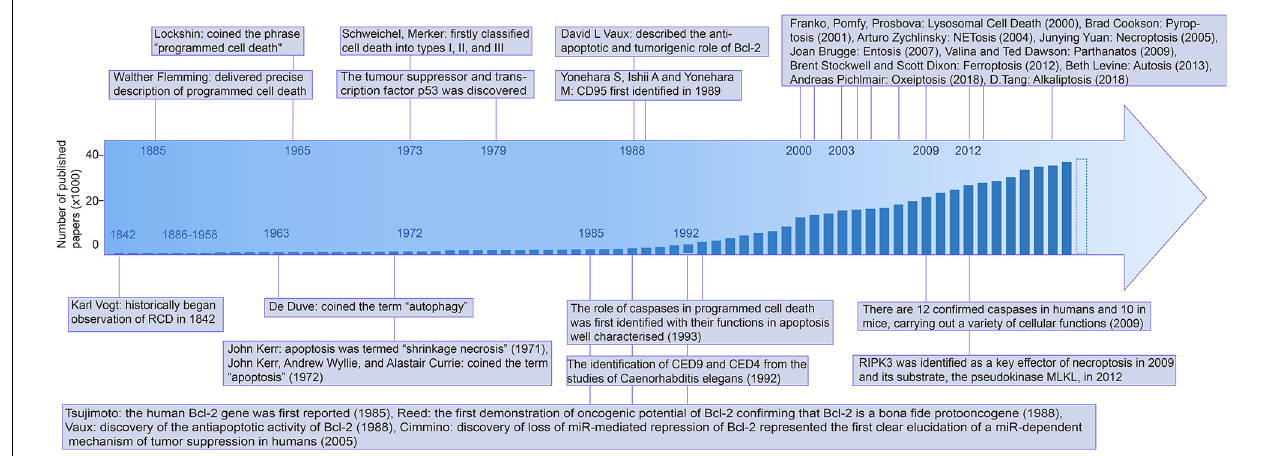
FIGURE 1 | Timeline of the mile stone of cell death research. Abbreviations: Bcl-2: B-cell leukemia/lymphoma-2, CED-9: Cell death abnormality gene 9, RIPK3: Receptor-interacting serine/threonine-protein kinase 3, MLKL: Mixed lineage kinase domain like pseudokinase, PCD: Programmed cell death, CD95: cluster of differentiation